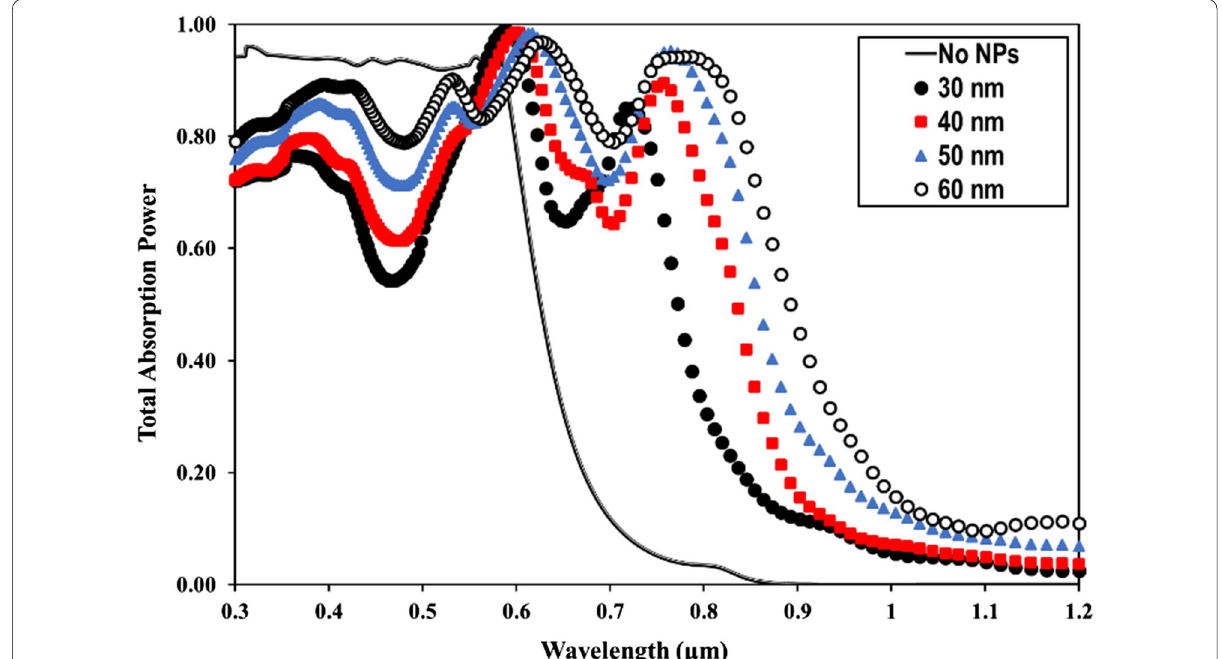
Fig. 3 The total absorption efficiency of GaAs NW with D / P ratios of 0.2 ( a ) incorporated with different Au NP sizes from 30 to 60 nm in diameter compared to bare